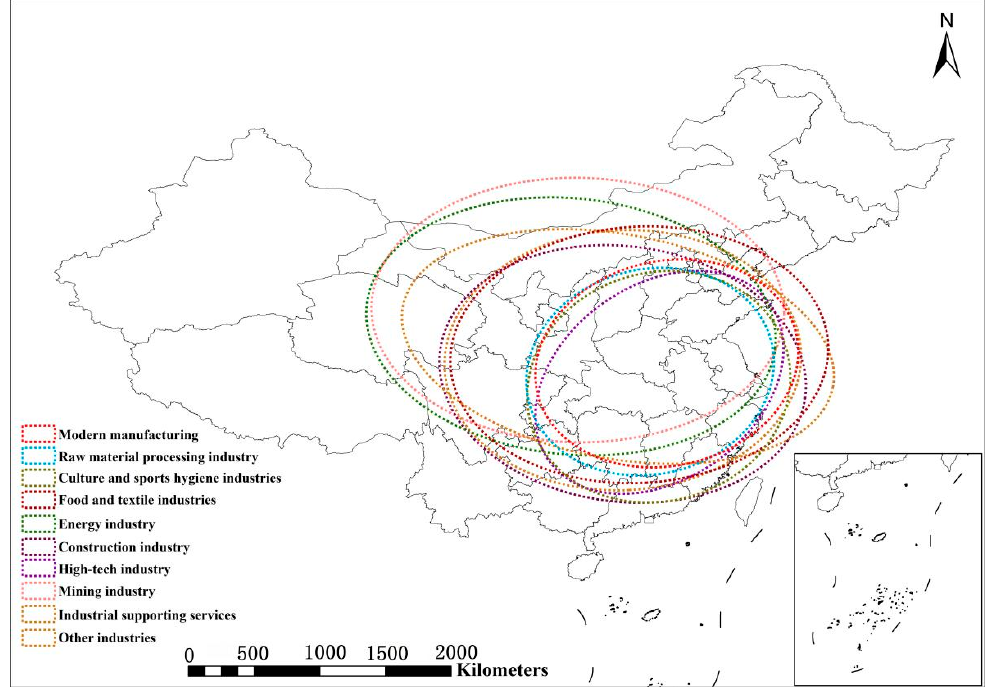
Figure 3. Standard deviation ellipses of various industrial land transfers in China.